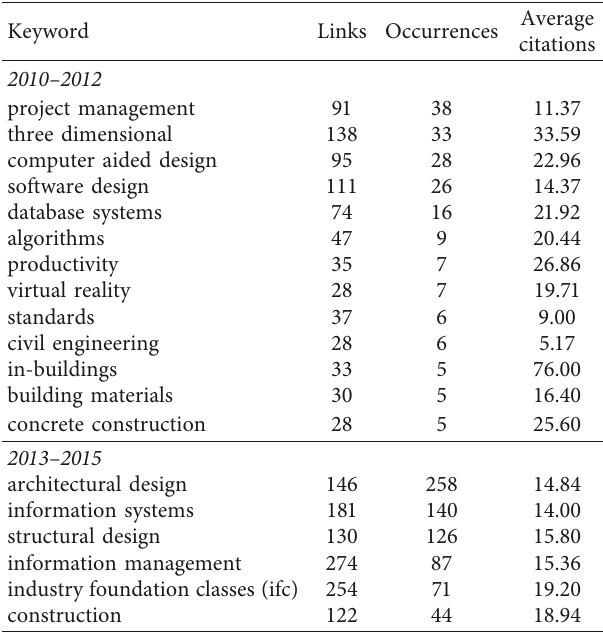
Figure 6: Cooccurrence map of keywords according to years. Table 5: Keyword analysis (Scopus, December